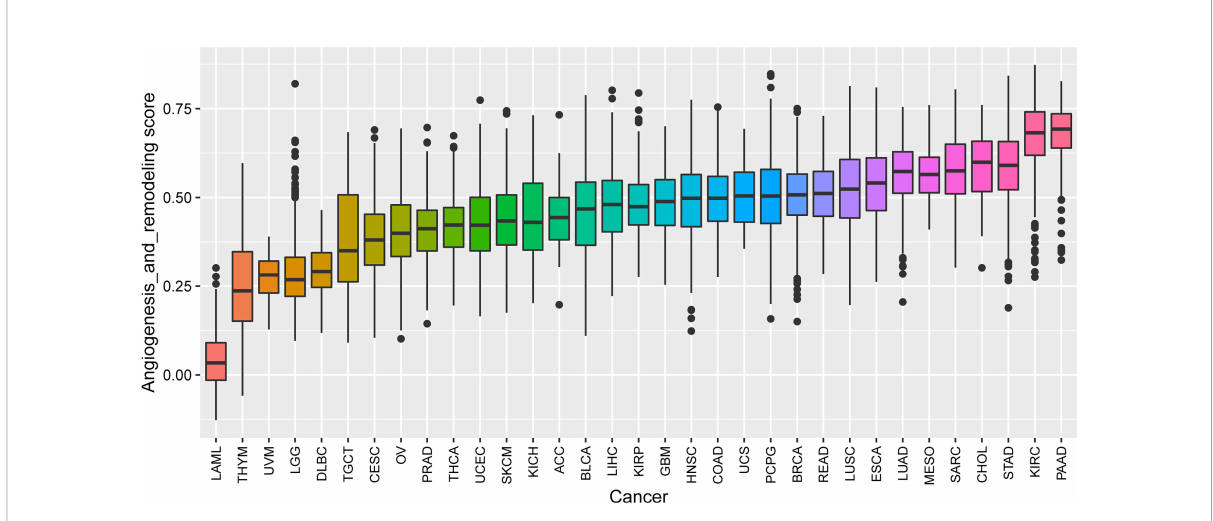
FIGURE 2 The AR score distribution in different cancer types based on datasets from TCGA. The distribution of the AR score in 33 tumors of TCGA (from low to high). The AR score was highest in Pancreatic Cancer (PAAD) and lowest in Acute Myeloid Leukemia